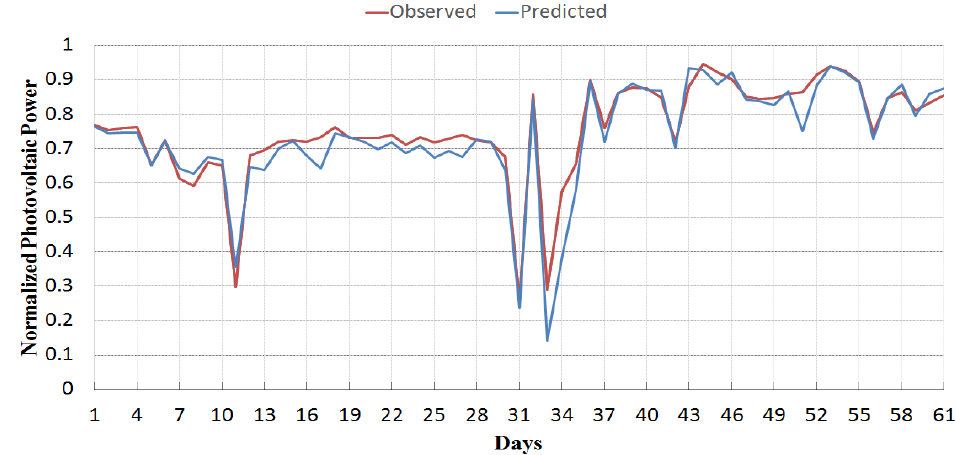
Figure 6. The predicted photovoltaic power values of the ALO-MLP method, which used H R , SR TH and SR DH inputs.